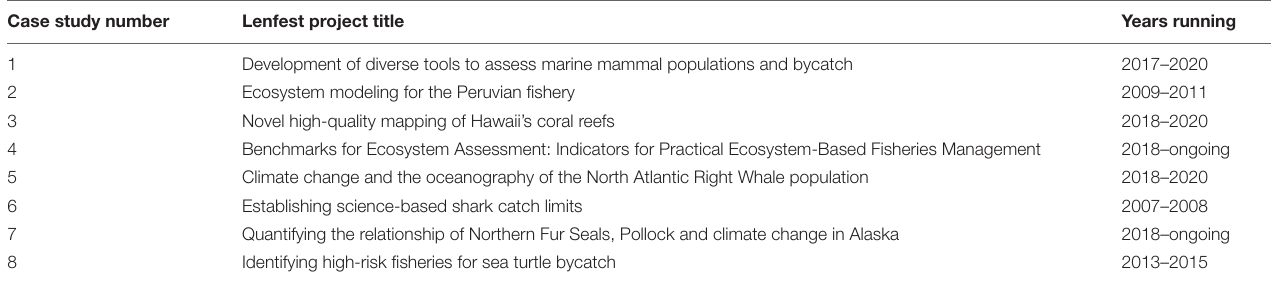
TABLE 1 | Overview of the 8 case studies that formed the basis of our